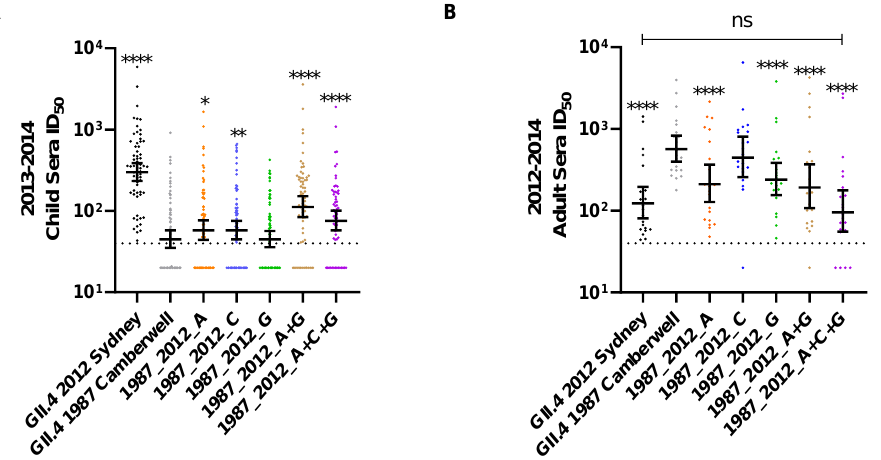
Figure 3. Antigenic site-specific nAb responses vary by age/exposure history. Surveillance sera from children ages ≤ 5 years ( n = 65) ( A ) and adults ≥ 15 years ( n = 21) ( B ) were evaluated for nAb antibody titer to GII.4 2012 Sydney, GII.4 1987 Camberwell, and antigenic site-chimera VLP comprised of GII.4 2012 Sydney antigenic sites in the backbone of GII.4 1987 Camberwell. Only samples with titer ≥ 50 to either GII.4 2012 Sydney or 1987 Camberwell were included in analyses to exclude subjects who are genetically resistant to GII.4 infection. Y-axis: reciprocal of the serum dilution at 50% inhibitory dose. Marker: one individual. Line: geometric mean titer. Error bars: 95% confidence intervals. Dashed line: limit of detection. * p = 0.02, ** p = 0.004, **** p < 0.0001 compared to GII.4 1987